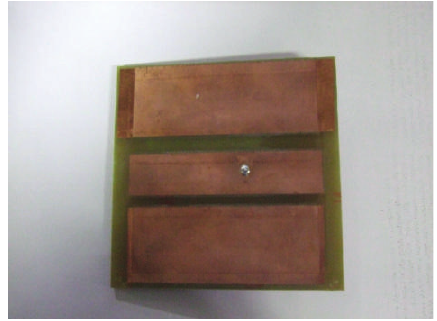
Figure 6: The realized broadband microstrip